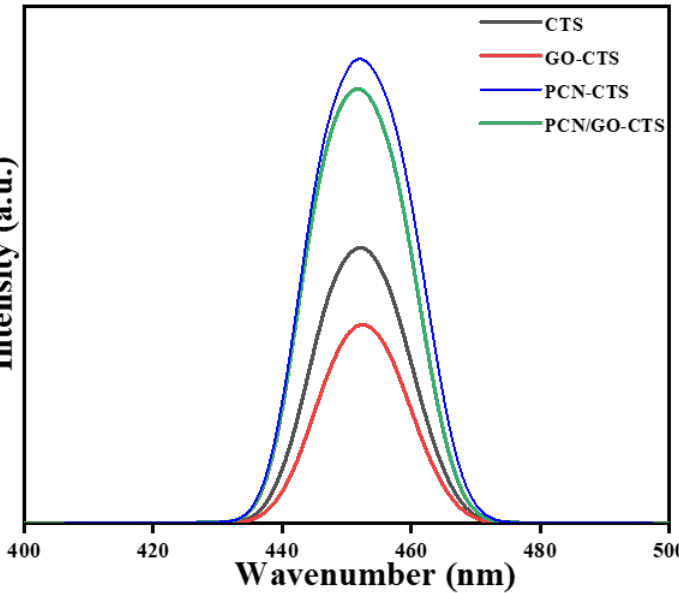
Figure 5. PL spectra of CTS, GO-CTS, PCN-CTS, and PCN/GO-CTS.